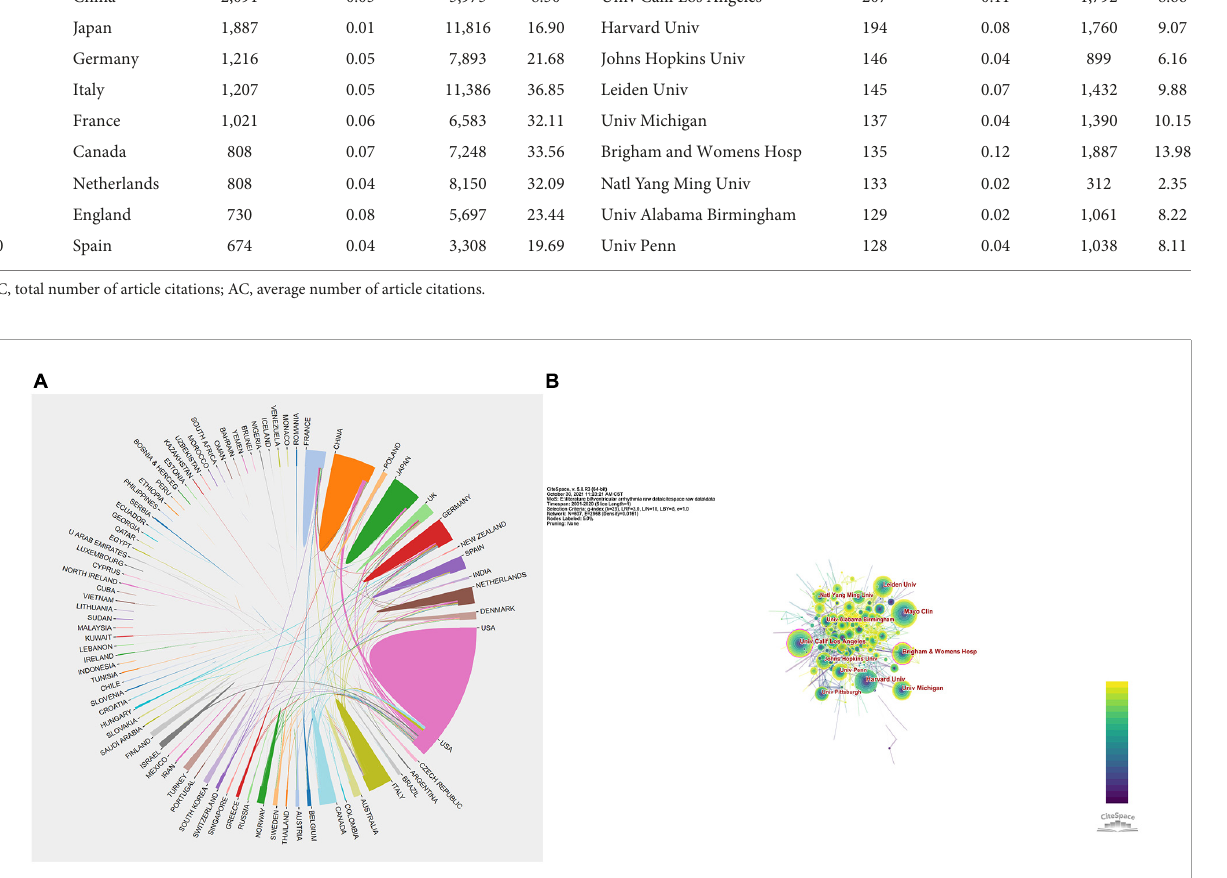
FIGURE2 Cooperative relationship and intensity among authors’ countries and affiliations. Cooperation network map of collaborating countries (A) and affiliations (B) for ventricular arrhythmia